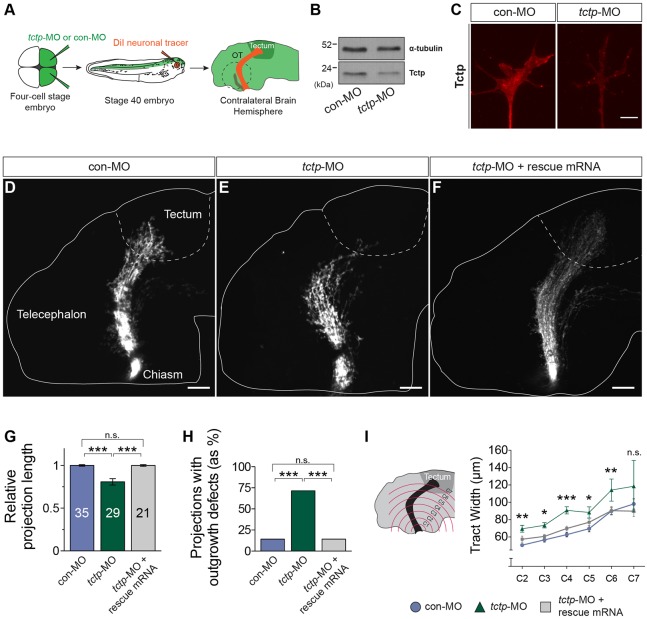
Tctp is required to establish correct retinotectal projections in vivo. (A) Experimental outline. OT, optic tract. Dashed line encircles the contralateral, DiI-filled eye. (B) tctp-MO leads to a specific knockdown in Tctp protein levels in the CNS, as evaluated by western blot analysis of stage 37/38 embryos using an anti-Tctp antibody. (C) Representative growth cones from control morpholino (con-MO)-injected and tctp-MO-injected embryos stained for Tctp. (D-F) DiI-filled retinotectal projections in MO-injected stage 40 embryos. Dashed lines approximate the boundary of the optic tectum, where RGC axons terminate. Injection of MO-resistant tctp mRNA (rescue mRNA) rescued the development of the retinotectal projection. (G) Relative projection lengths in the various MO-injected backgrounds. Mean±s.e.m.; n, number of brains analysed; ***P<0.0001, Kruskal–Wallis test. (H) Number of embryos displaying axon extension defects. con-MO versus tctp-MO, P<0.0001; tctp-MO versus tctp-MO+rescue mRNA, P=0.0002; Fisher's exact test; performed on number of observations but plotted as percentages. (I) Mean (±s.e.m.) optic tract widths. con-MO versus tctp-MO, **P<0.01 (C2), *P<0.05 (C3), ***P<0.0001 (C4), *P<0.05 (C5), **P<0.05 (C6), two-way ANOVA with Bonferroni correction (for details of statistics see Fig. S2F). C2-7 denote imaginary, evenly spaced hemi-circumferences centred on the optic chiasm. Scale bars: 5 μm in C; 100 μm in D-F. n.s., not significant.